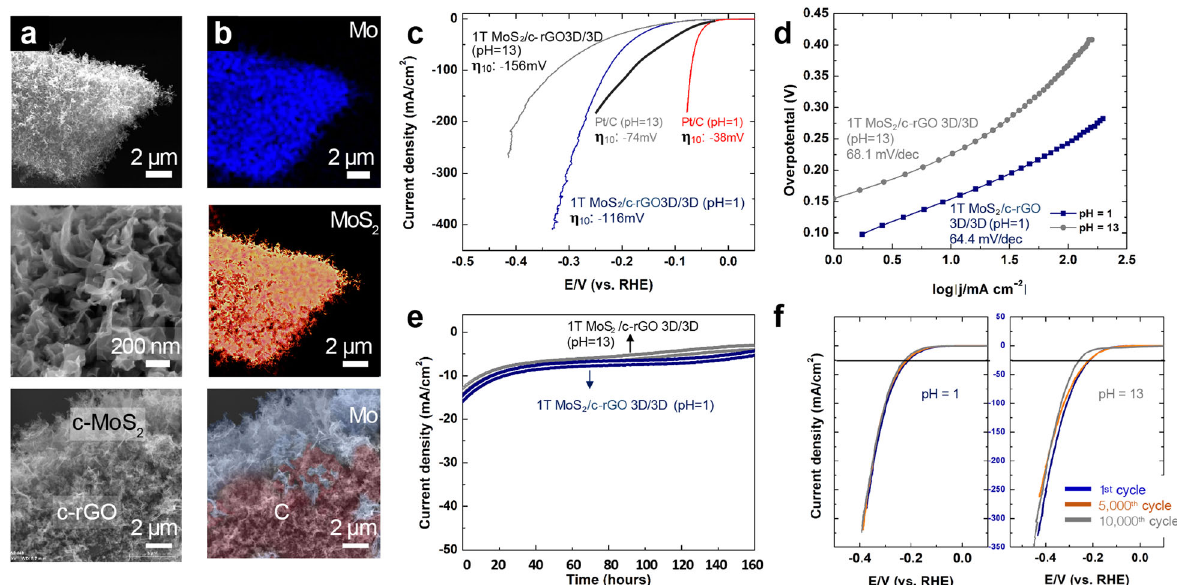
Fig. 7 Comparison of HER metrics in both 0.5 M H2SO4 and 1 M KOH. a SEM images taken at different perspectives, including (top) tilted-, (middle) top-, show a highly uniform and dense coverage of 1T ′ MoS 2 /c-rGO 3D/3D heterostructures supported on CC. (Bottom) A cross-sectional view of an area where top layers of c-MoS 2 were removed, reveals the formation of vertical 3D/3D heterostructures. b Corresponding EDS mapping shows the chemical composition and spatial distribution of each element: Mo in blue, C in red, and an overlap of both Mo and S, respectively. HER metrics extrapolated from c LSV curves, and d Tafel slopes of 1T MoS 2 /c-rGO 3D/3D heterostructures display comparable performance in both 0.5 M H 2 SO 4 (line in naval blue) and 1 M KOH (line in gray). In contrast, Pt/C degrades signi fi cantly in 1 M KOH. e Time-dependent current density curves of HER electrodes made of 1 T ′ MoS 2 / c-rGO 3D/3D heterostructures taken under respective η 10 for 180 h together with f LSV curves after continuous potential sweeps at 5 mV s − 1 in 0.5 M H 2 SO 4 (left), and 1 M KOH (right) after 1st, 5000th, and 10,000th potential sweeps show electrochemically stable output even after prolonged